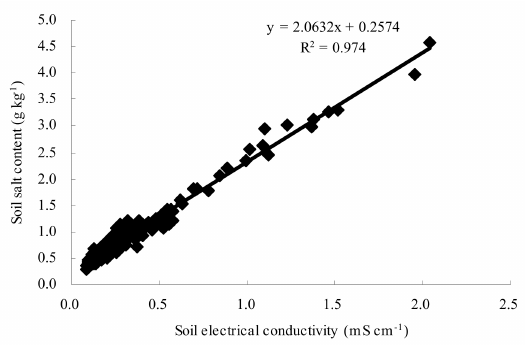
Figure 6. Correlation between the soil electrical conductivity and soil salt